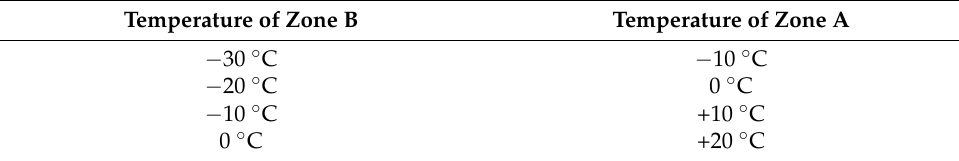
Figure 12. Division zones of PVB material (( A ) — heated zone, ( B ) — unheated zone). A gradient value of 20 ◦ C was assumed for the purpose of the calculations. The PVB polymer properties for each zone were defined upon the basis of the tests discussed in Section 2.1.2. As in point 3, no effect of temperature on the mechanical properties of the glass was assumed. Simulations of the head impactor hitting the central point of the windscreen were performed for a set of temperatures as in Table 3. Table 3. Division of windscreen zones in relation to